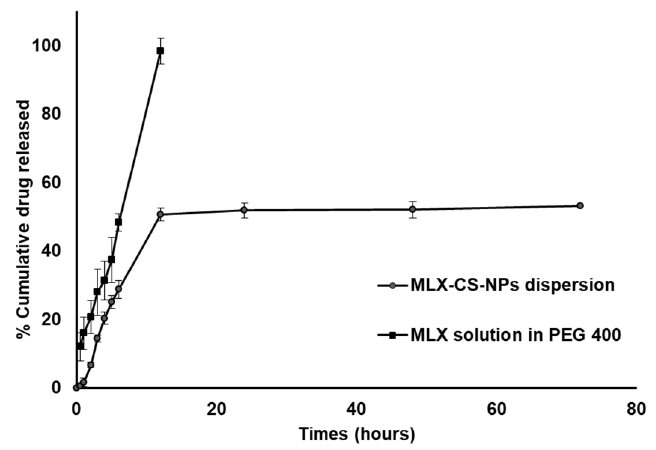
Figure 3. In vitro release profile of MLX-CS-NPs dispersion and MLX solution in PEG 400 using PBS (pH 7.4) as the release medium. Data are presented as the mean ± SD ( n = 3). Abbreviations: MLX-CS-NPs; MLX/chitosan nanoparticles.